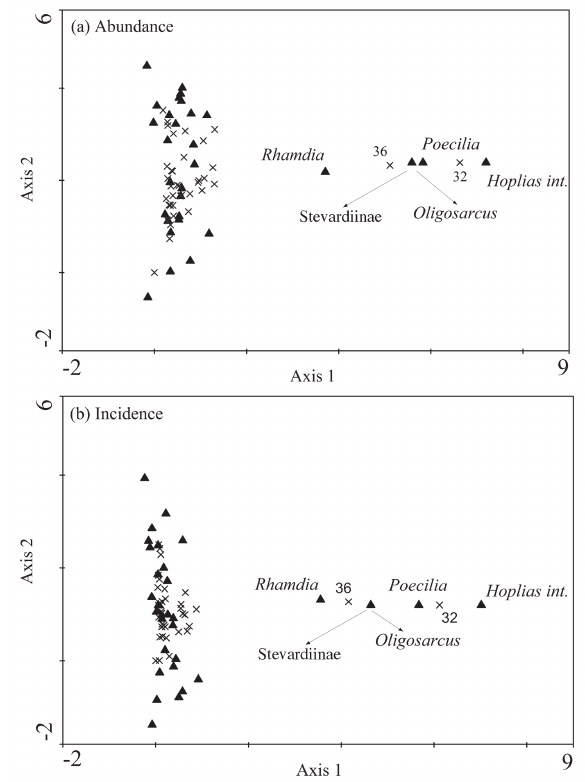
Fig. 2. Detrended correspondence analysis (DCA) of fish abundance (a) and incidence (b) along the sampling sites. The species are shown in triangle and sampling sites in X-mark.